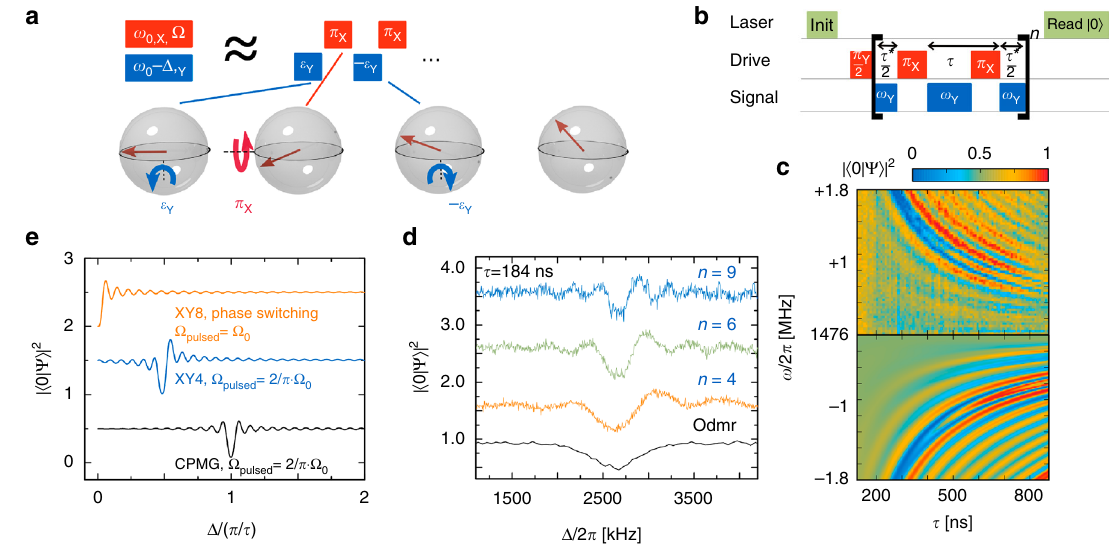
Fig. 3 Pulsed Mollow absorption spectroscopy (sub fi gures ordered clockwise). a The sideband transitions of the CW protocol in Fig. 2a can be understood as a dynamical decoupling protocol by dissecting the strong drive into a train of π pulses and the probe into a train of weak pulses ( ϵ ). The detuning Δ of the probe translates into periodic inversions of its axis, which are resonantly recti fi ed by the strong drive. b Pulse sequence for high-frequency sensing, a direct implementation of the interpretation given in a . π pulses at frequency ω 0 emulate a strong drive to resonantly enhance a weak signal at frequency ω = ω Δ . The pulse spacing τ incorporates the duration of a π pulse. τ * is obtained from τ by subtracting the π pulse duration. c Pulsed Mollow resonance, 0 + as measured on a NV center (upper plot) and simulated (lower plot). A resonance at Δ = π / τ is framed by sidebands with nodes at Δ = ± π / τ ± k π / T (with k 2 N , sequence duration T = 2n τ , cycle number n = 4). d Linewidth of the resonance. The line narrows below the natural linewidth 1 = T (cid:1) optically detected magnetic resonance (odmr) experiment, see also Supplementary Note 1) for sequences longer than the dephasing T > T (cid:1) spectral response to sensing sequences with different decoupling protocols. The pulse spacing between 24 π pulses was kept constant at τ = 127.6 ns. The stated effective Rabi frequencies are for Rabi oscillations driven on the Mollow resonance. ‘ XY8, phase switching ’ refers to the protocol of Fig. 4. More detailed discussion in Supplementary Note 4. Data traces in d , e have been shifted vertically for better comparison by an offset of 1.0. The ODMR trace in d is shifted horizontally by 2623